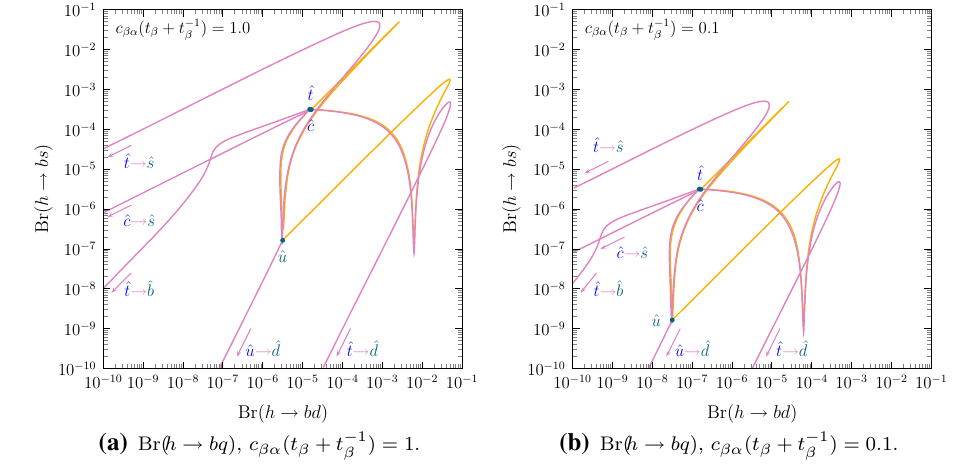
Fig. 6 Br ( h → bs ) vs. Br ( h → bd ) FCNC processes in gBGL